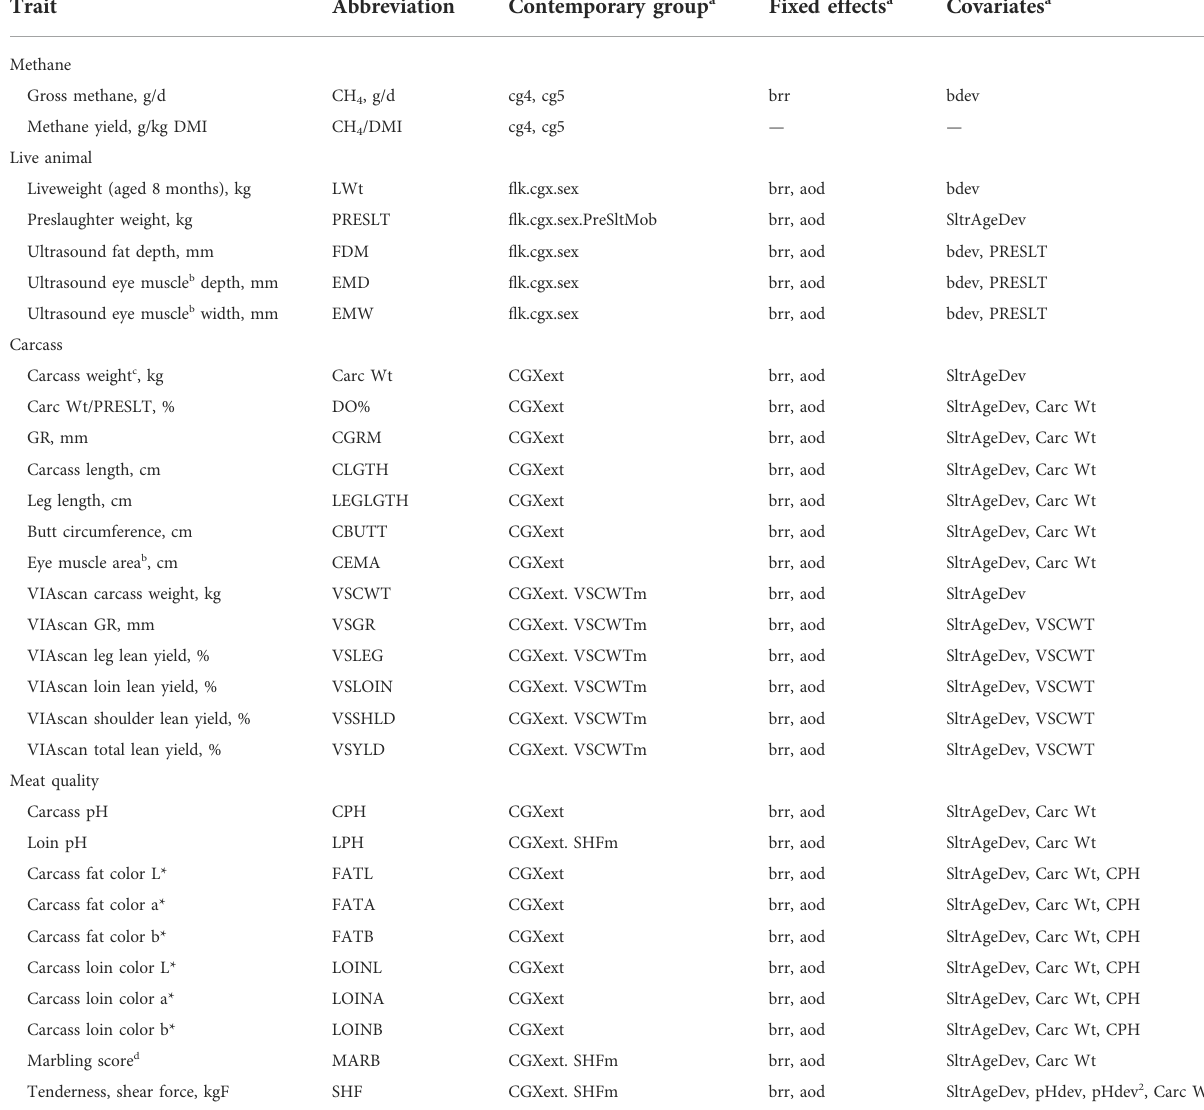
TABLE 1 Methane, live animal, ultrasound, carcass, and meat quality trait description with details of fi nal mixed model effects and covariates for genetic parameter